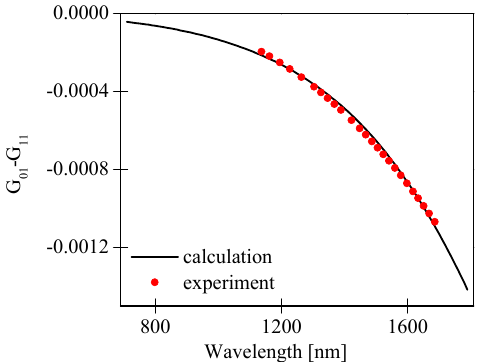
Figure 6. Comparison of measured and calculated difference in the group modal birefringence G 01 –G 11 of the LP 01 and LP 11 modes in the investigated HB MOF with boron-doped inclusion.